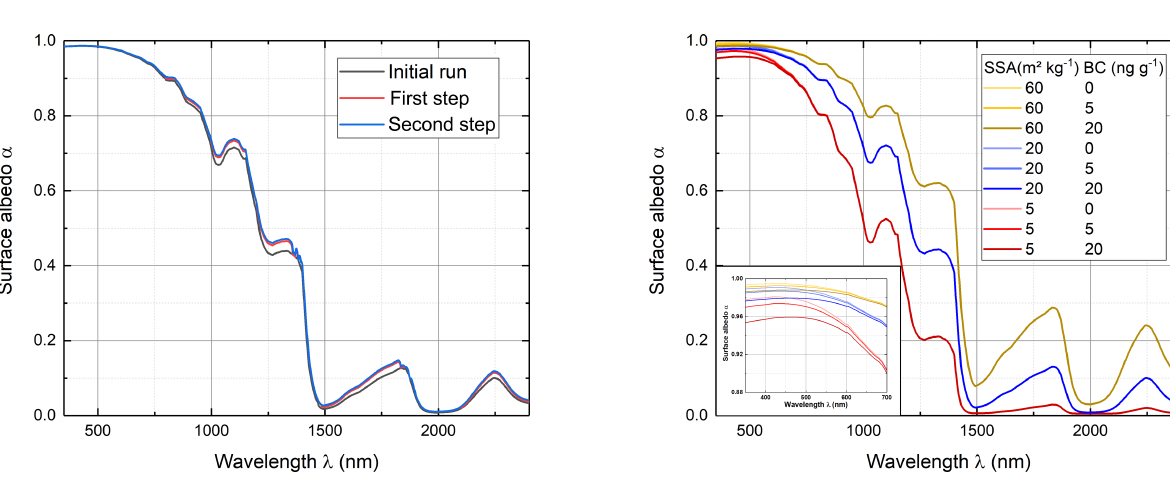
Figure 3. Change of the spectral snow albedo for cloudless con- ditions with a SZA of 60 ◦ due to the iterative adjustment by the coupled atmosphere and snow radiative transfer models. The initial run assumes a direct-to-global ratio of zero.